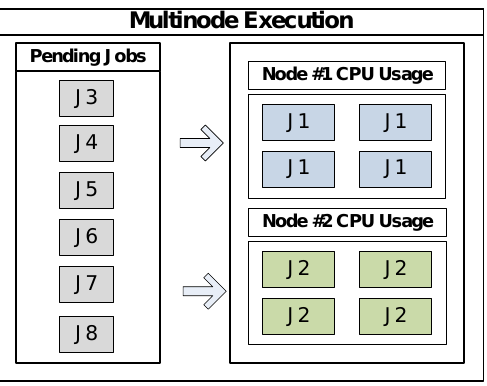
Figure 15. Multinode execution